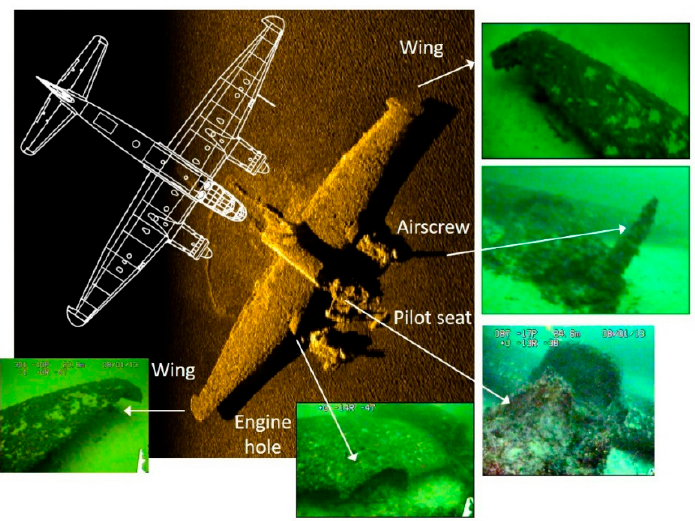
Figure 18. Identification of selected parts of the wreck of bomber on the basis of data recorded with ROV and side-scan sonar.